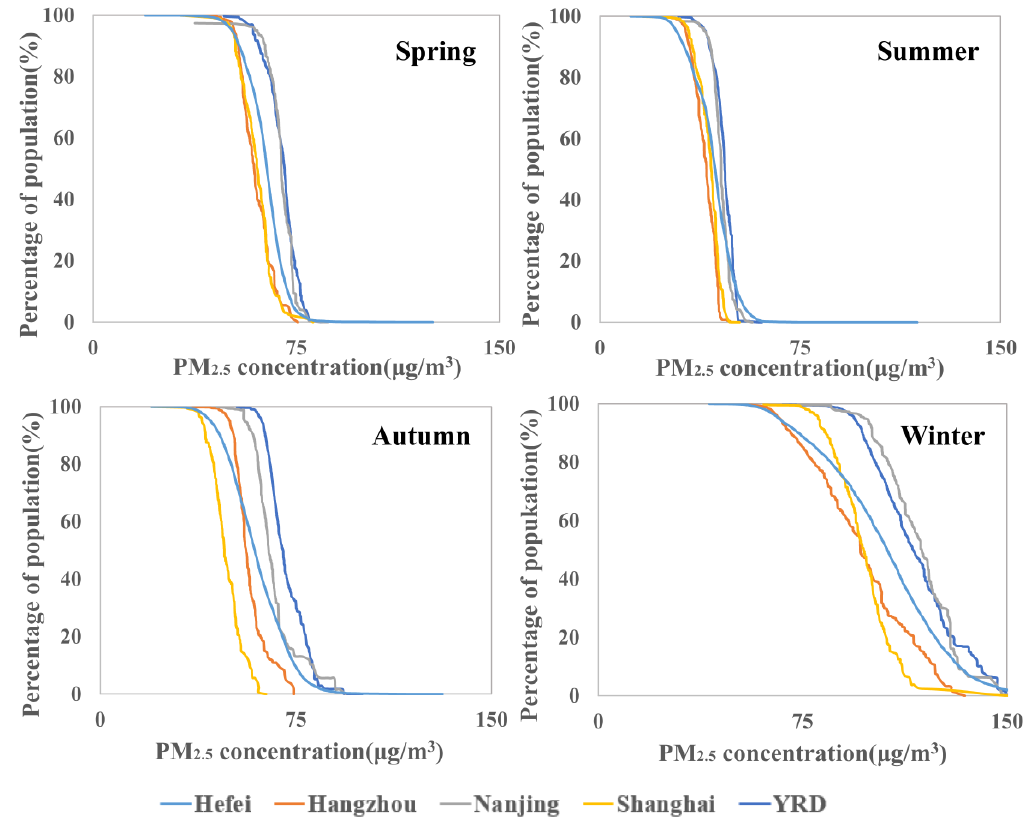
Figure 7. The percentage cumulative distribution (%) of the population exposed to PM 2.5 in the four major cities and the YRD Region.